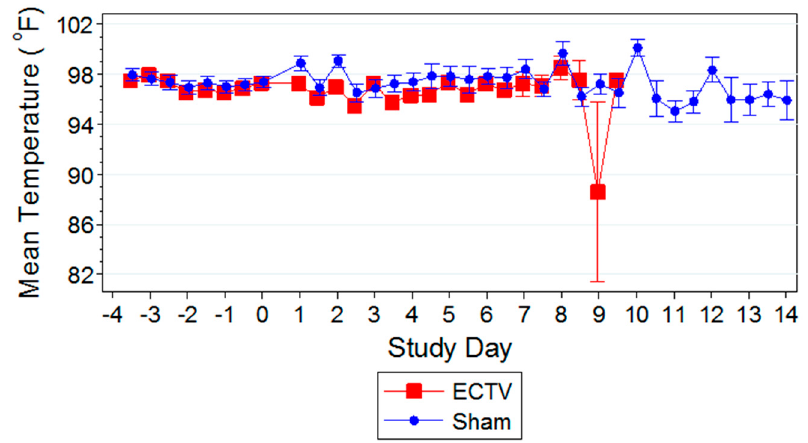
Figure 4. Temperature (°F) with 95% confidence intervals for ectromelia virus (ECTV) and sham mice. Statistically significant changes compared to baseline occurred at random intervals following infection, however were not significant between groups until nine days PI. On study day 9, a dramatic drop in mean temperature was observed in the ECTV-Mos infected group.